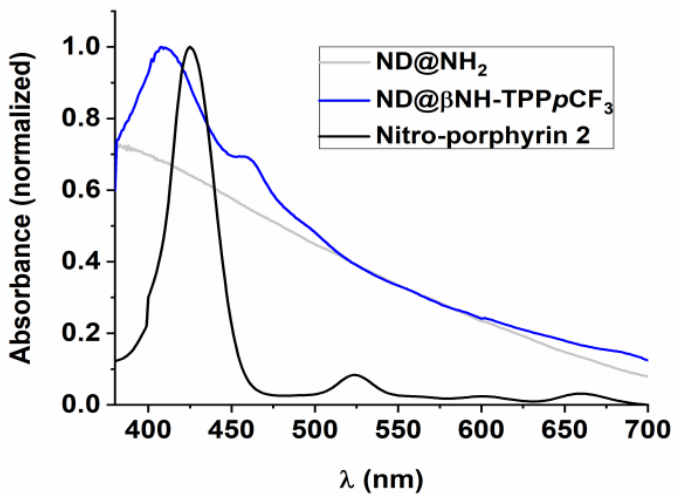
Figure 2. Normalized UV–Vis absorption spectra of ND@NH 2 (grey line), ND@βNH-TPP p CF 3 (blue line) and nitro-porphyrin 2 (black line) in DMF.